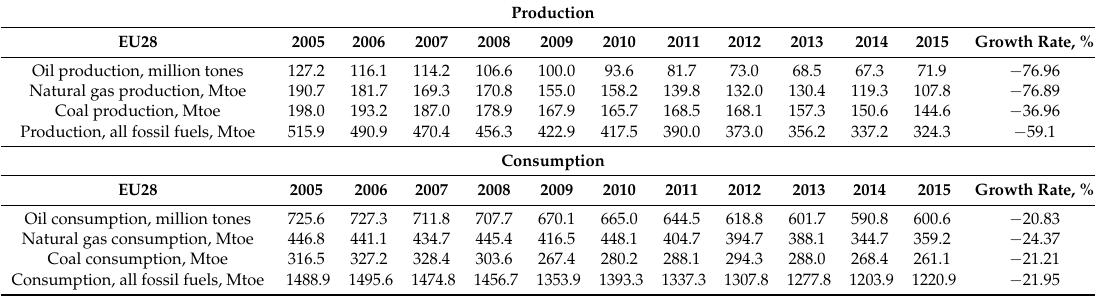
Table 1. Production and consumption of fossil fuels in EU28 over 2005–2015